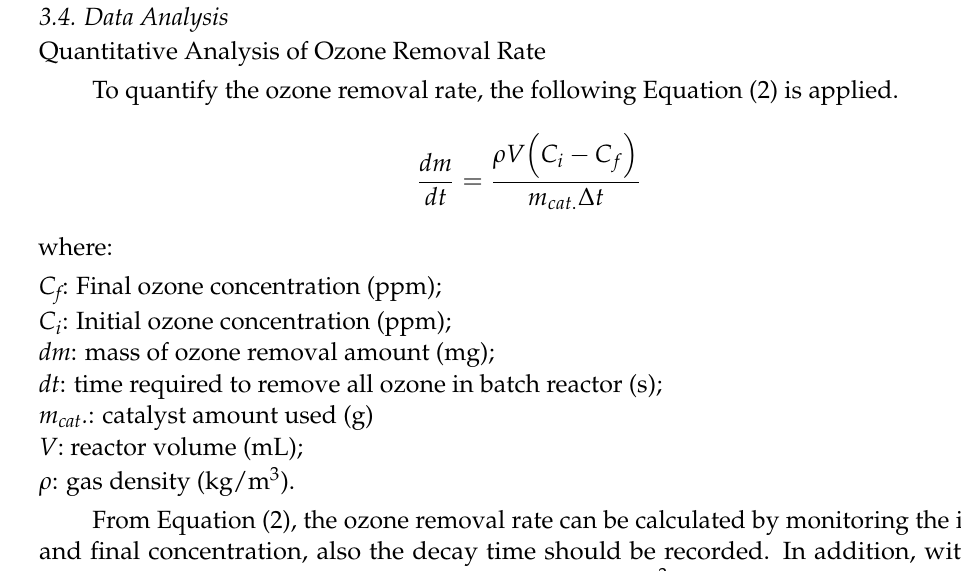
Figure S4: Photocatalytic decomposition of ozone in the batch system by SrTiO 3 under UV (365 nm) irradiation for three repeated tests, Figure S5: Photocatalytic decomposition of ozone in the batch system by SrTiO 3 :Rh under UV (365 nm) irradiation for three repeated tests, Figure S6: Photocatalytic decomposition of ozone in the batch system by P25 under UV (365 nm) irradiation for three repeated tests, Figure S7: Photocatalytic decomposition of ozone in the batch system by SrTiO 3 under Xe lamp (500 W, broad band, with AM 1.5 G filter) irradiation for three repeated tests, Figure S8: Photocatalytic decomposition of ozone in the batch system by SrTiO 3 :Rh under Xe lamp (500 W, broad band, with AM 1.5 G filter) irradiation for three repeated tests, Figure S9: Photocatalytic decomposition of ozone in batch system by P25 under Xe lamp (500 W, broad band, with AM 1.5 G filter) irradiation for